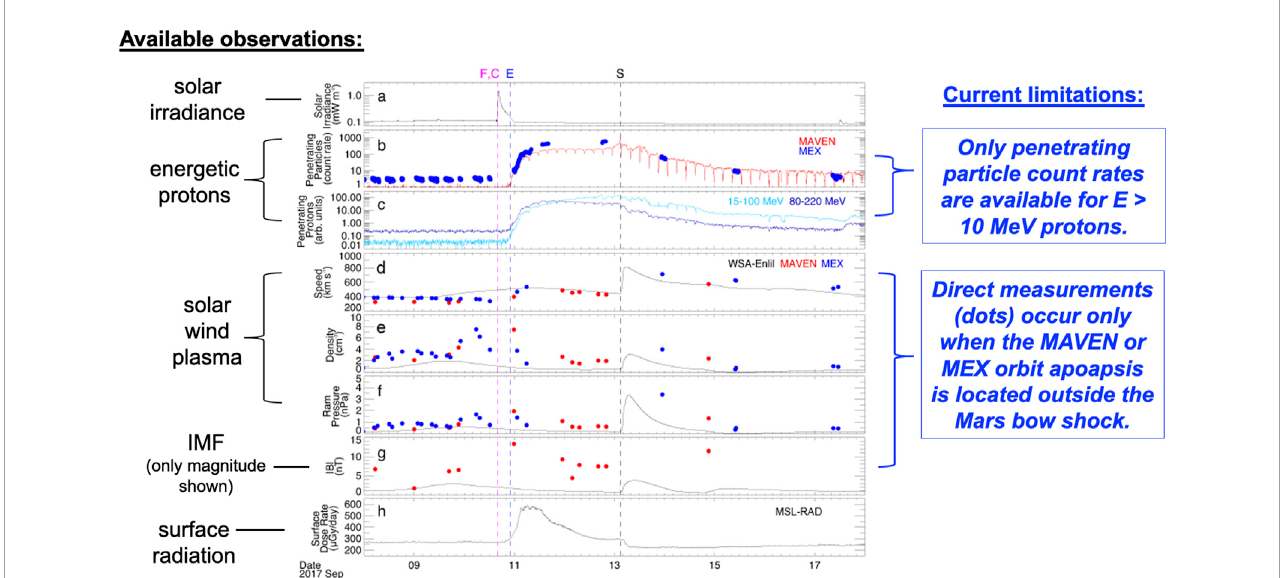
FIGURE 1 Example of a missed opportunity to study in detail an ICME at Mars due to observation gaps during the September 2017 event period. The MAVEN apoapsis location entered the Mars bow shock, while the observation coverage was limited for Mars Express (MEX) due to power restrictions. The figure is adapted from Lee et al.